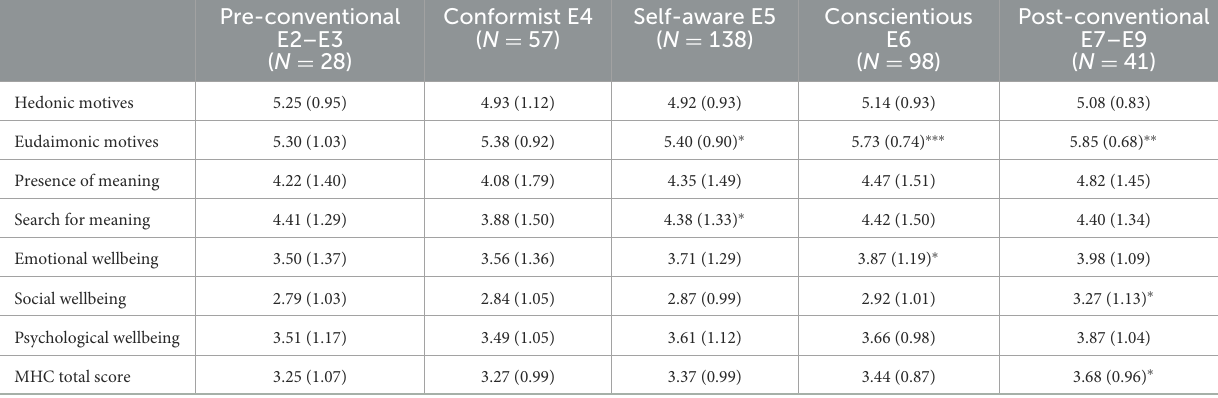
TABLE 1 Descriptive statistics for the individuals at different ego development stages, M